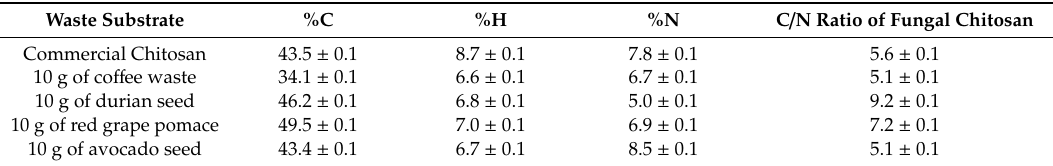
Table 5. Elemental analysis of fungal chitosan extracted after fermentation on various waste substrates.